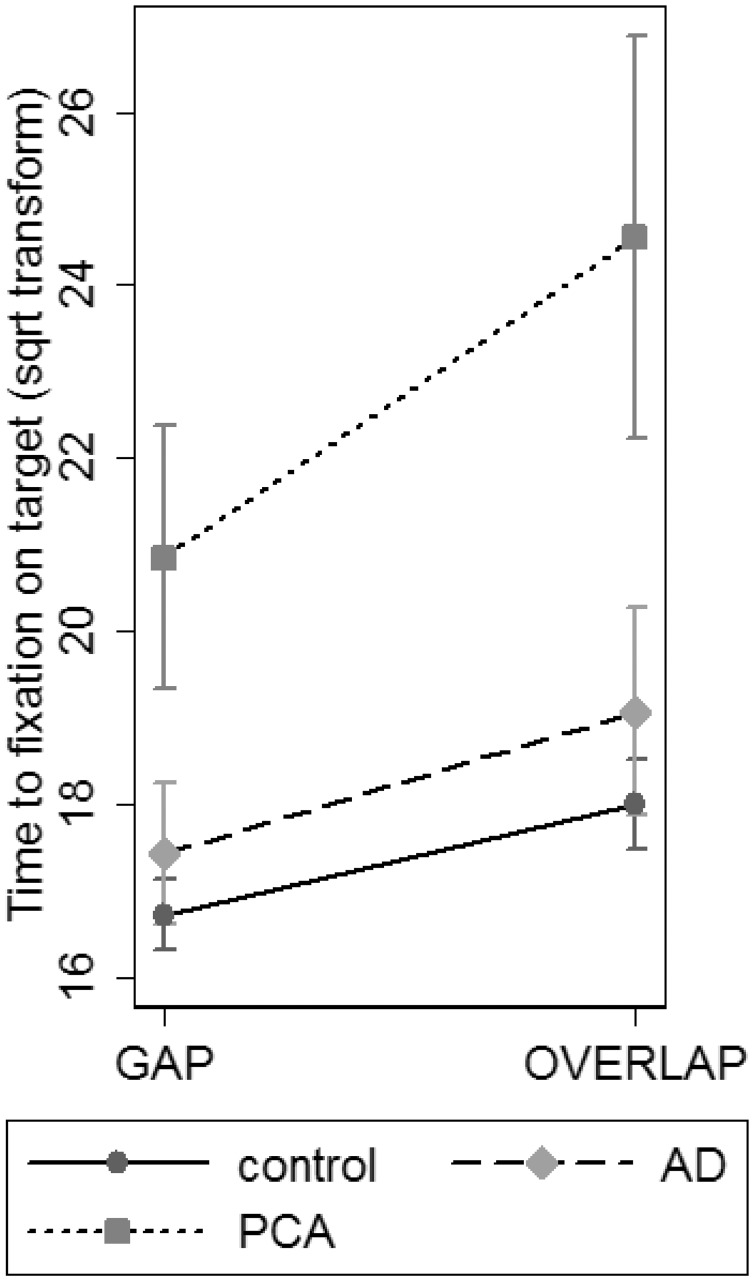
Interaction figure showing greater effect of overlap condition on time taken to reach the interest area in patients with PCA relative to patients with typical Alzheimer’s disease and controls. AD = Alzheimer’s disease.